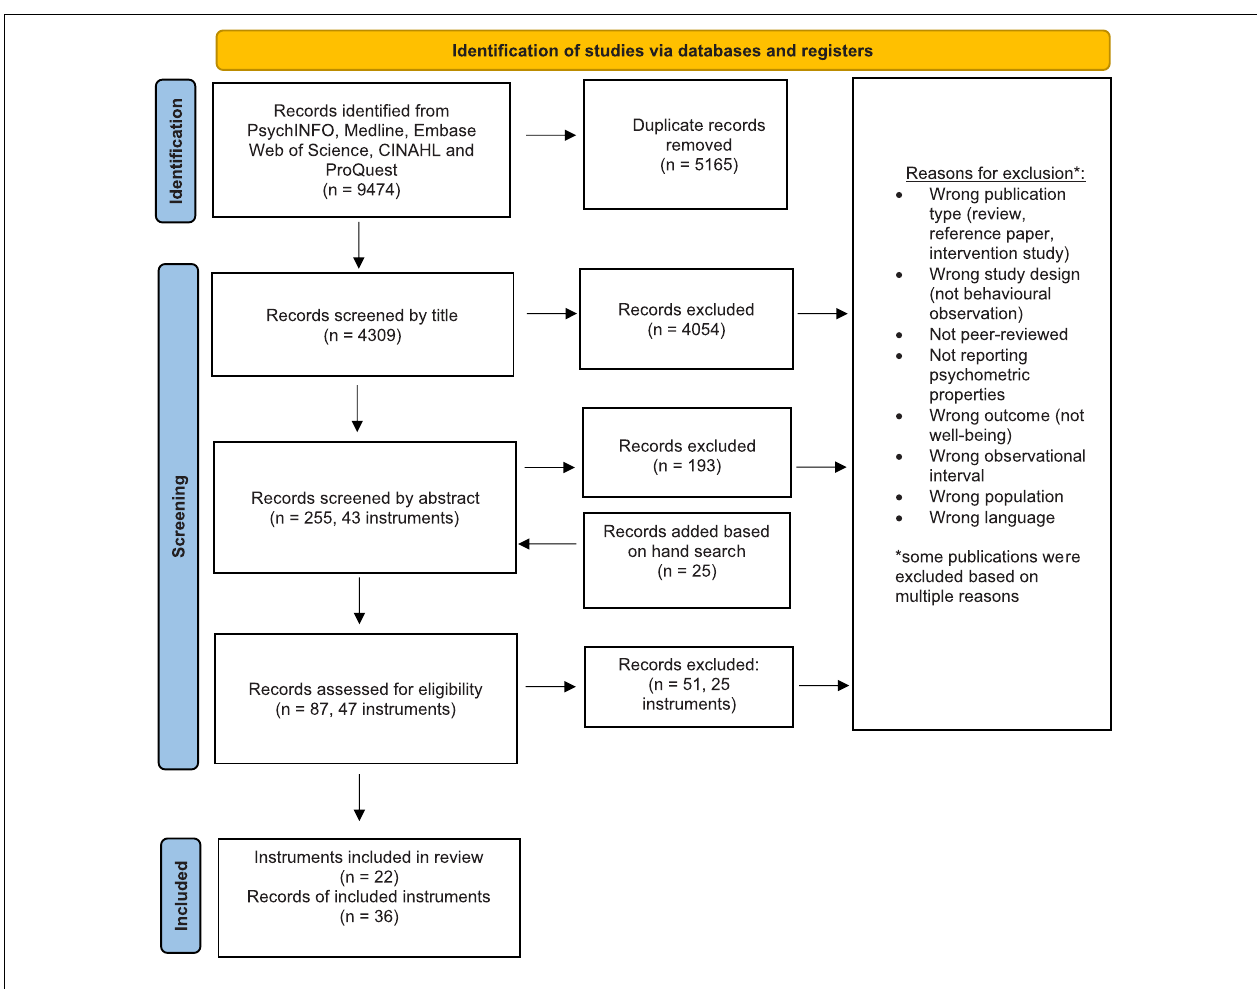
FIGURE 2 | PRISMA Flow chart of search